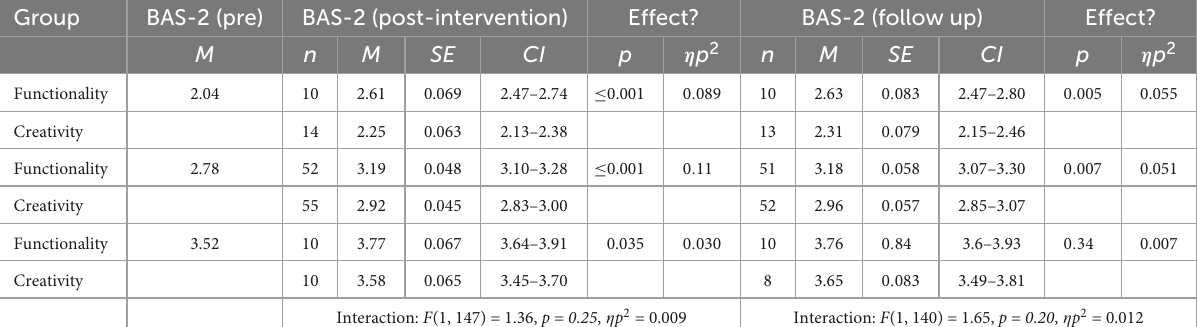
TABLE 3 Summary of completer analysis for body appreciation (BAS-2), including estimated marginal means and effects of the intervention at baseline values of BAS-2 one-standard deviation below the mean, the mean, and one-standard deviation above the mean, as well as the interaction effect (baseline BAS-2 and study arm) on BAS-2 post-intervention ( n = 151) and at 1-month follow up ( n =